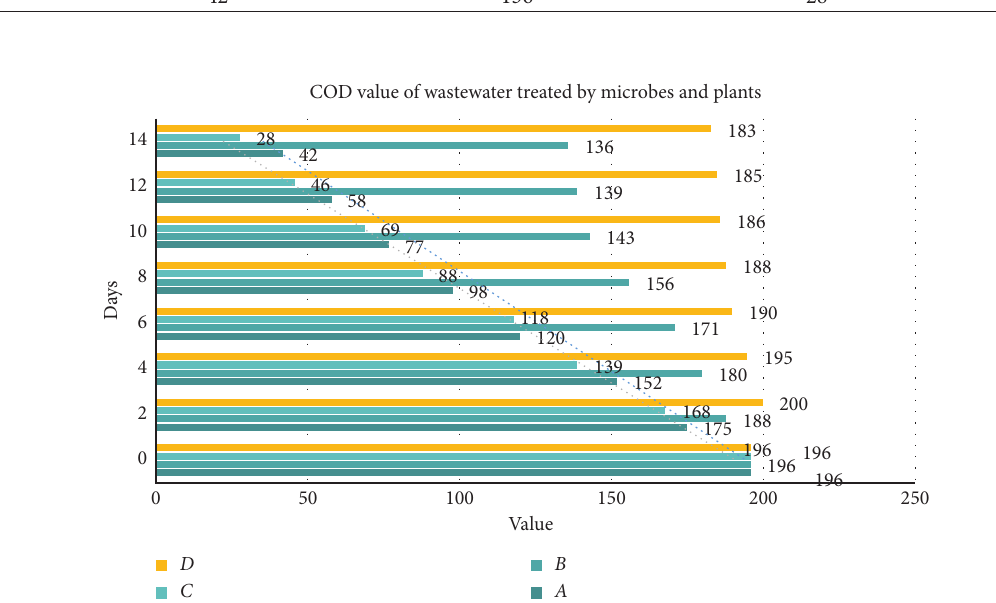
Figure 6: Changes of the COD value of wastewater treated by microbe plants.